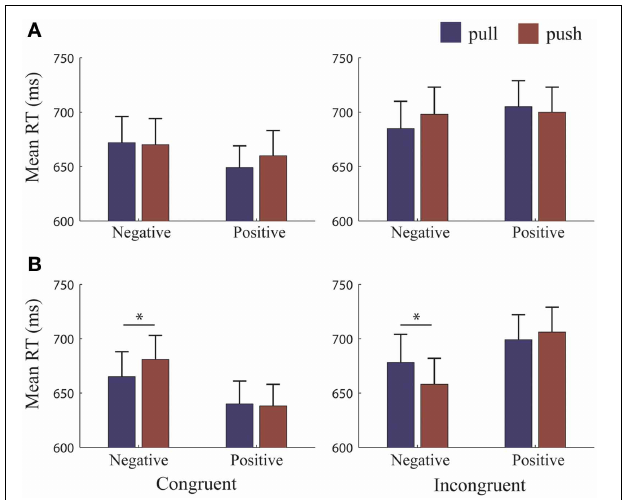
FIGURE 2 | RTs for each reference-condition. Mean reaction times (RTs) for each reference-frame. (A) Object-reference condition: RTs did not differ when pulling or pushing to approach and avoid. (B) Self-reference condition: RTs were significantly faster for pulling to avoid and pushing to approach negative pictures. Error bars ( + 1 SE); blue bars, pull; brown bars, push. ∗ , significant at > = 0.001 level.